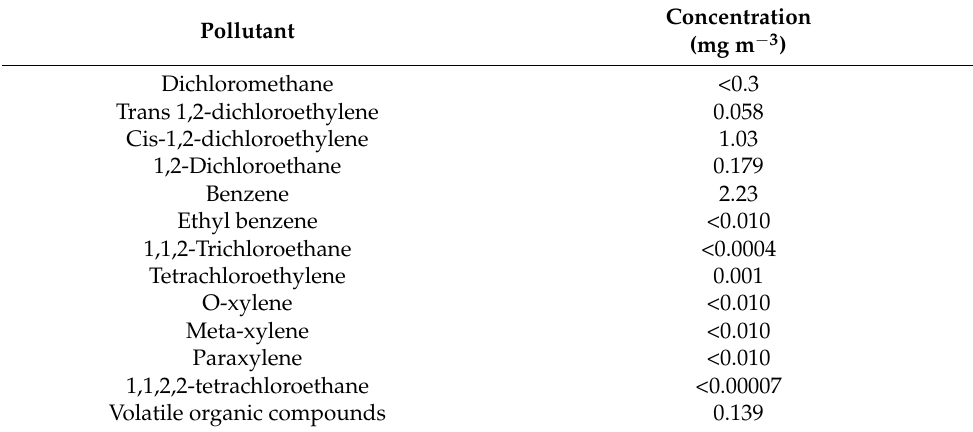
Table 4. Concentration of pollutants in dry tail gas.